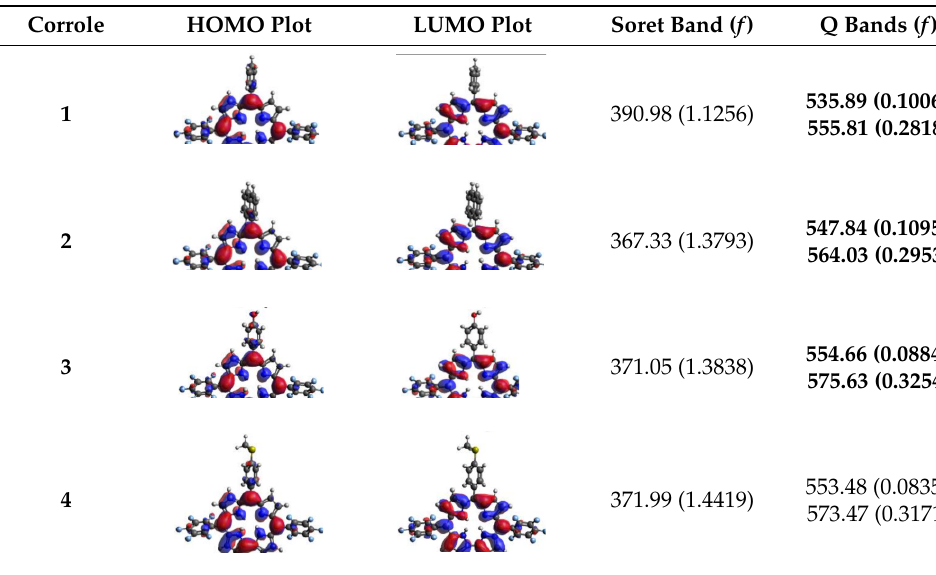
Table 2. HOMO-LUMO plots for the lowest energy electronic transitions (S 0 → S 1 ), transition energies in nm, and oscillator strengths (in parentheses), ƒ, for the main peak at the Soret band, and the two main peaks of the Q-band in DCM, for corroles 1 – 4 . The data for the Soret peak was calculated as the average for the two theoretically intense peaks (see Supplementary Materials). This was done to allow a better comparison with the experimental